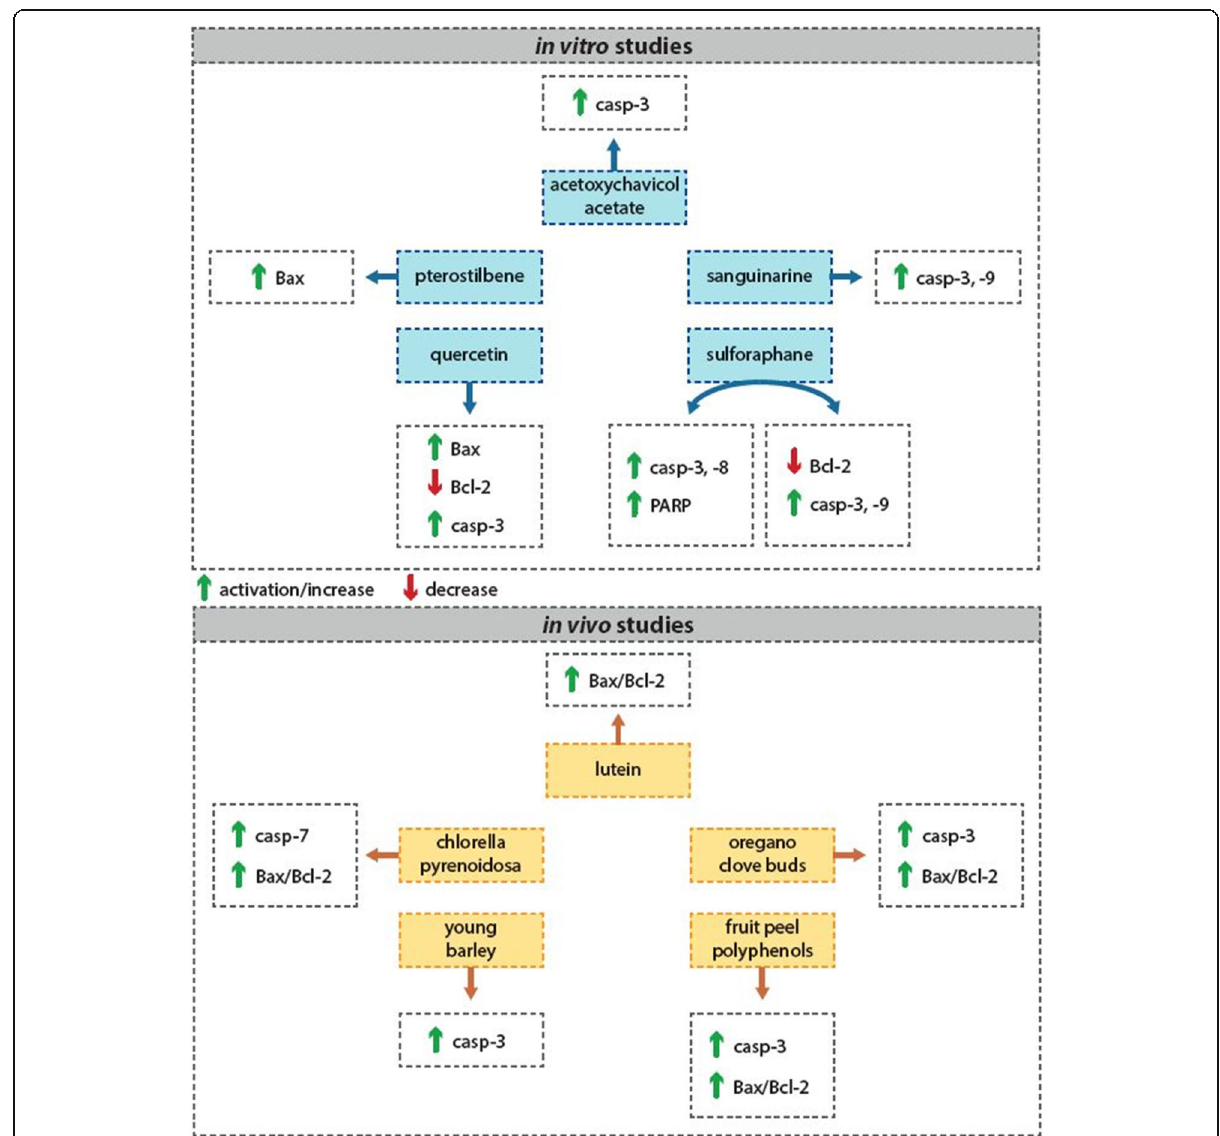
Fig. 3 Isolated phytochemicals and/or mixture of phytochemicals contained in functional foods induce apoptosis of breast cancer cells through different mechanisms of action –– evidence of experimental studies. For more details, see the text –– the section “ Induction of apoptosis